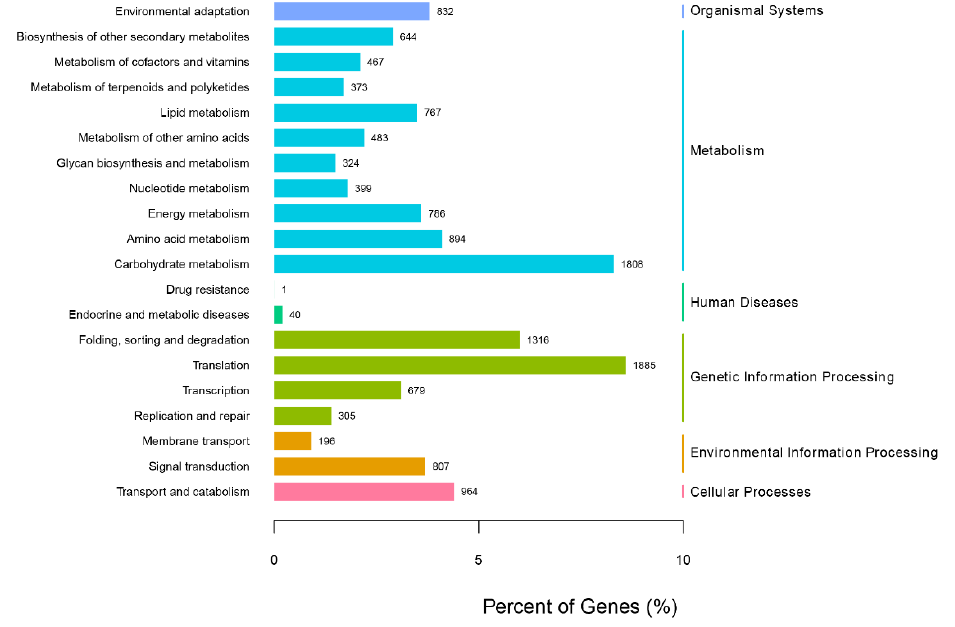
Figure 4. The KEGG pathway analysis of G. macrophylla transcriptomic unigenes. Table 1. The KEGG pathway annotation analysis of G. macrophylla transcriptomic unigenes associated with secondary